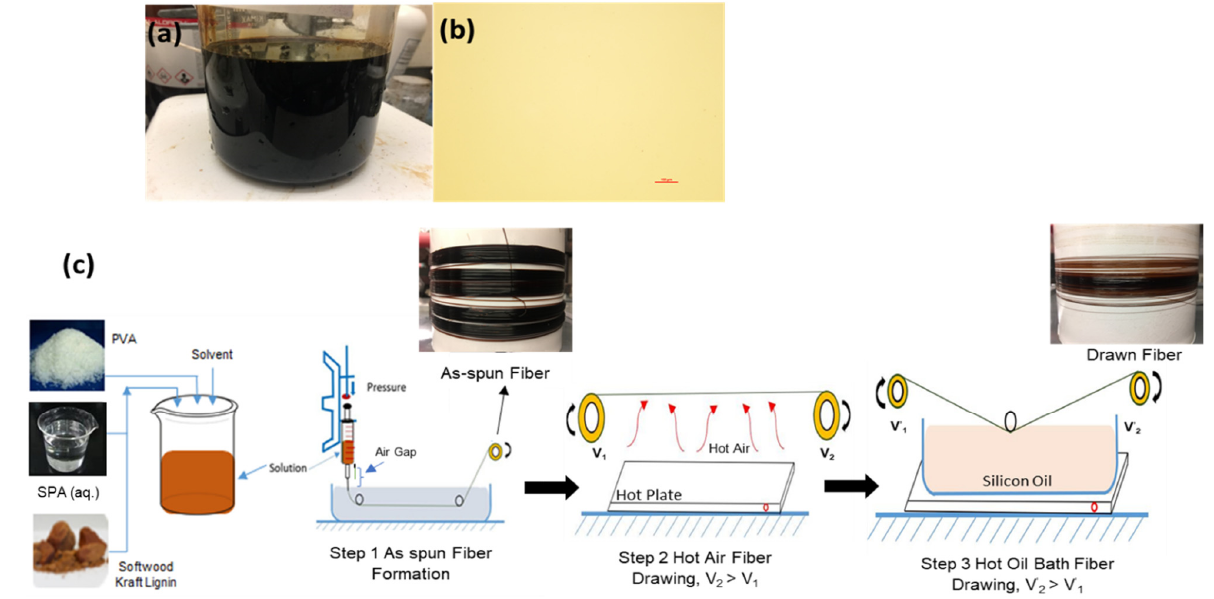
Figure 1. The homogeneity of lignin/PVA dopes is visible within ( a ) digital photograph and ( b ) optical micrograph of Lig5/PVA5 dope; ( c ) schematic for the dry-jet gel-spinning of Lig5/PVA5 fibers shows three processing steps: as-spun fiber formation (Step 1), hot air fiber drawing (Step 2), and hot oil multi-stage fiber drawing (Step 3).